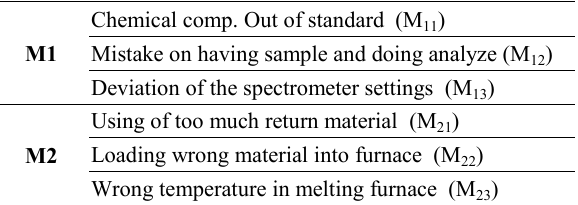
Table 6. Potential failure modes